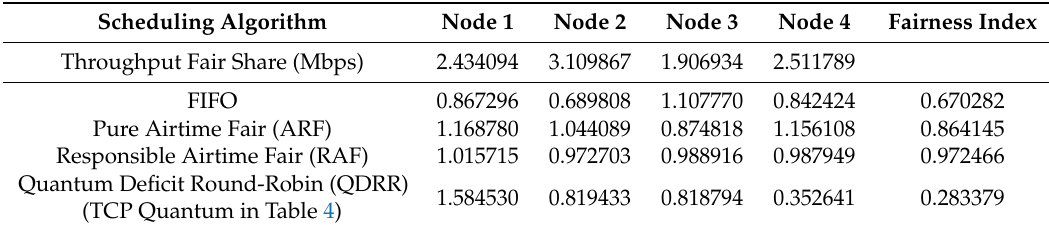
Table 7. Throughput Achieving Ratio and Fairness Index in TCP Traffic with Mobility.